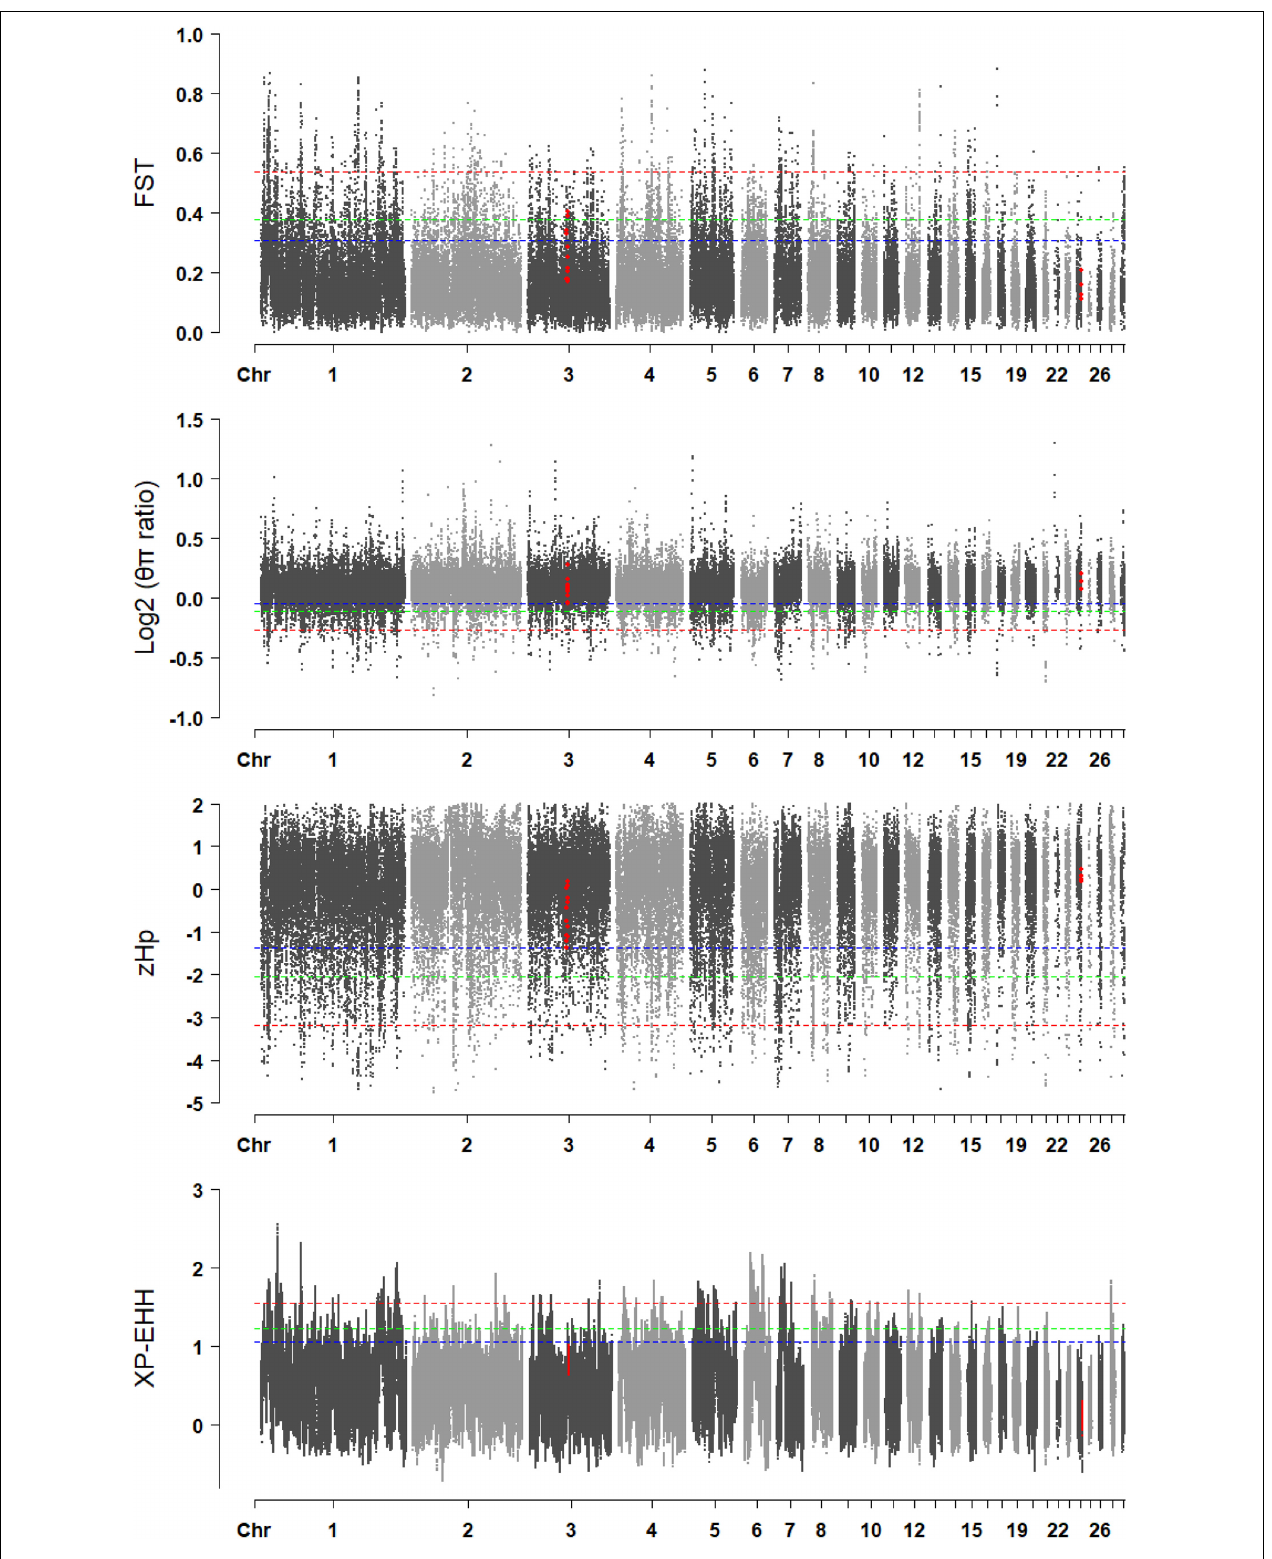
FIGURE 7 | The visualization of the selective sweep analysis. The horizontal blue, green, and red lines indicate the thresholds for 10% genome-wide significance, 5% genome-wide significance, and 1% genome-wide significance, respectively.